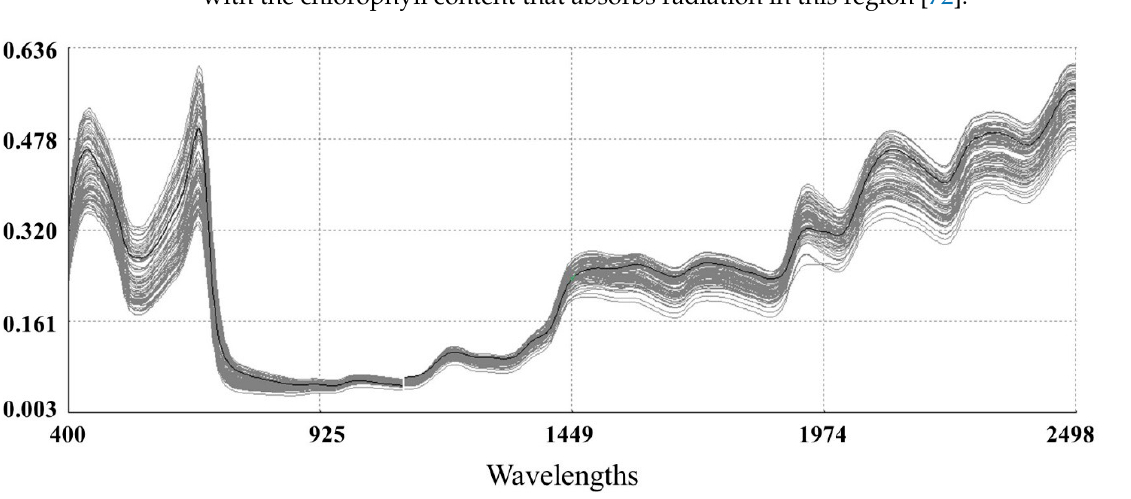
Figure 6. Second derivative spectra (2, 5, 5, 2; SNV + DT) of the raw optical data for mangetout samples in the range of 400 to 2500 nm, together with the most relevant absorption bands.